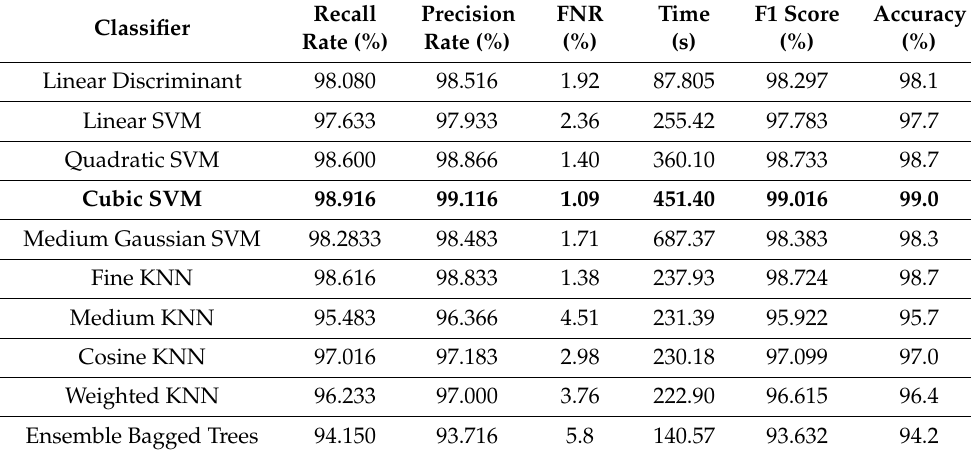
Table 7. Achieved results on KTH dataset after best feature selection using KcWKNN. The bold represents the best obtained values.